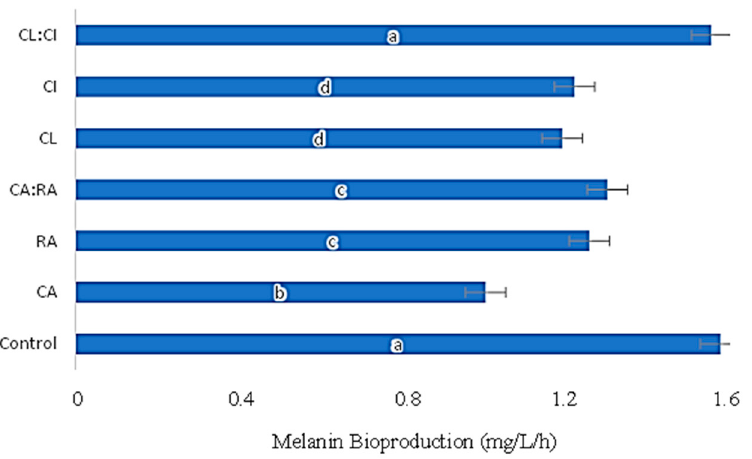
Figure 4. P. putida ESACB 191 melanin bioproduction (mg/L/h) by action of several C. cardunculus extracts: CL:CI—50% Leaf decoction + 50% Inflorescence decoction. CI—Inflorescence decoction. CL—Leaves decoction. CA:RA—50% Chlorogenic acid + 50% Rosmarinic acid. RA—Rosmarinic acid. CA—Chlorogenic acid. The concentration 1 mg/mL was used for all samples tested in Müller–